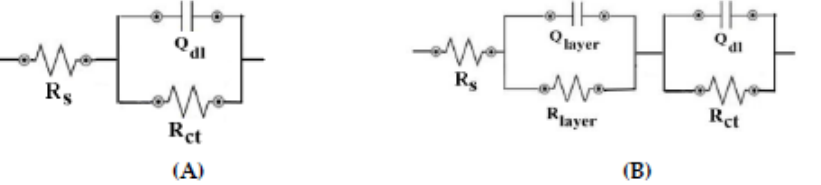
Figure 4. Equivalent electric circuits R s (Q dl R ct ) ( A ) and R s (Q layer R layer )(Q dl R ct ) ( B ) used for fitting experimental